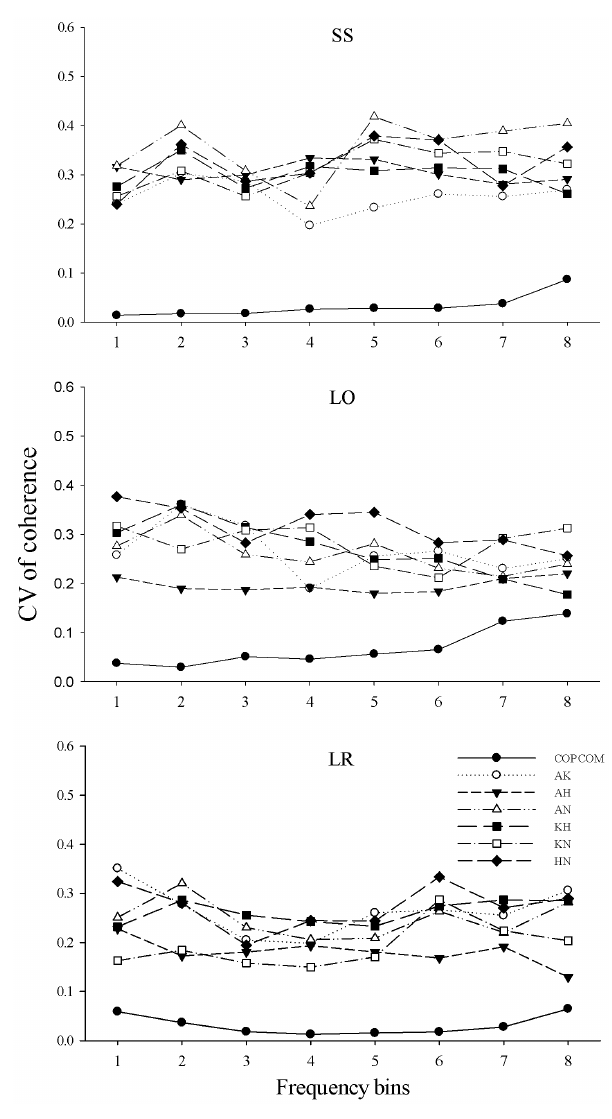
Figure 3. Coefficient of variation of coherence (group mean) for all pairs of joint synergies and COP-COM coupling at different standing conditions. Anatomical abbreviations and frequency bins are as in Fig. 2. Frequency bins are as in Fig. 2.